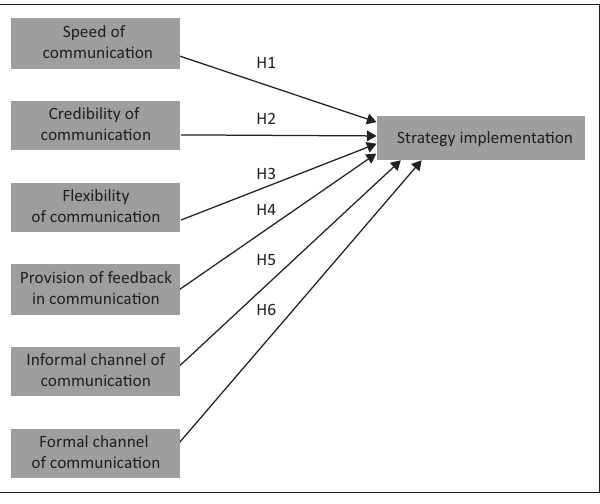
FIGURE 1: Initial hypothesis